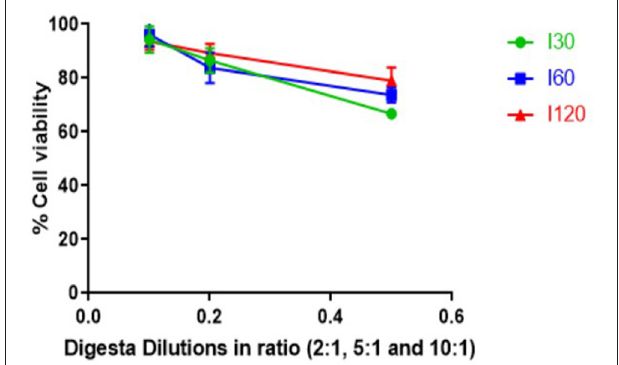
FIGURE 3 | Effect of digesta prepared from T. ferdinandiana on Caco-2-HT29-MTX-E12 coculture cell viability in vitro using CyQUANT ® NF cell proliferation assay. Results are expressed as mean ± SEM of two independent experiments with 4 replicates in each ( n = 8). I30, intestinal 30min; I60, intestinal 60min; and I120, intestinal 120min.